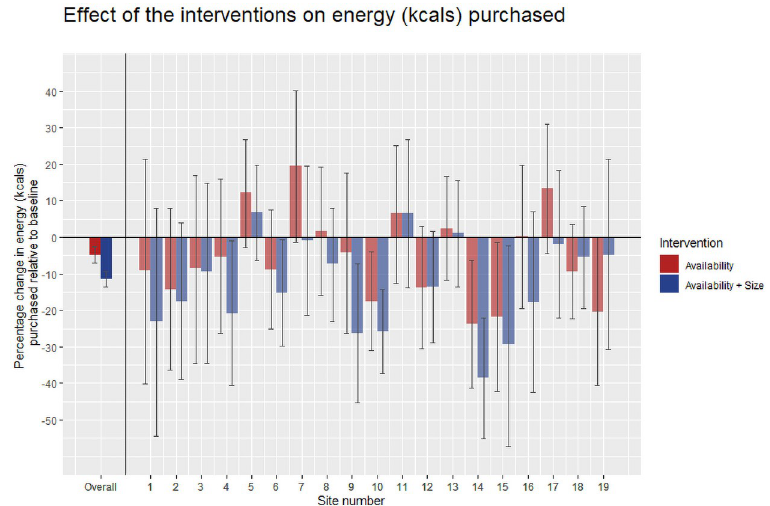
Fig 3. The effects of availability and availability plus size on energy (kcals) purchased per day relative to baseline. Error bars represent 95% CIs for the overall effects and 99.9% CIs (Bonferroni adjustment) for the site effects.